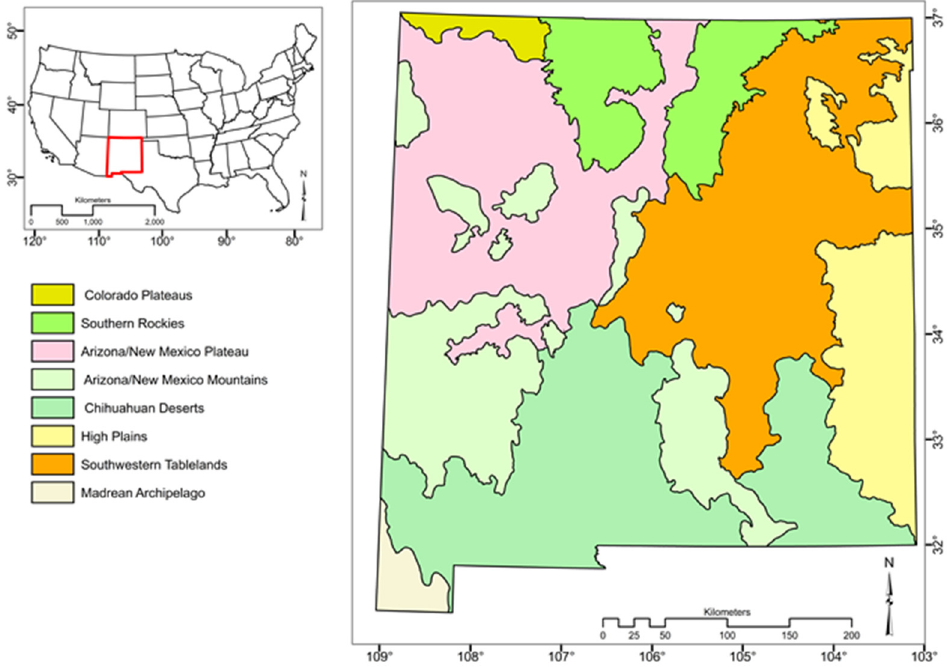
Figure 1. A map showing the location of the New Mexico, the contiguous USA (red polygon), and the nine ecoregions within New Mexico [41].